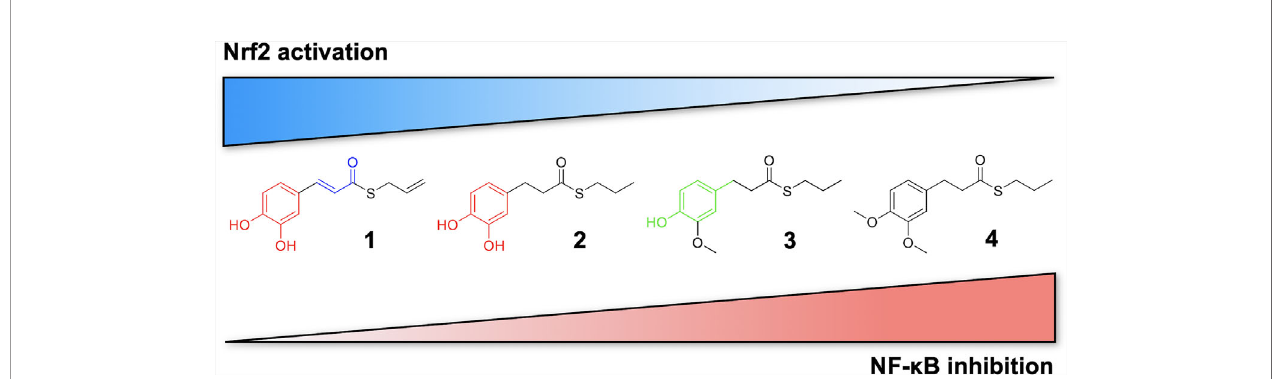
FIGURE 7 | Differential modulation of Nrf2 and NF- k B intracellular signaling pathways by compounds. Electrophile 1, carrying both the catechol moiety (red) and the a , b -unsaturated carbonyl group (blue), is the most active Nrf2 inducer, while being devoid of activity on NF-kB pathway. Conversely, the non-electrophilic compound 4, synthesized to exclude eventual oxidative transformation of the methoxyphenol ring (green) of 3 into reactive metabolites, is the most potent NF-kB inhibitor, with no impact on Nrf2